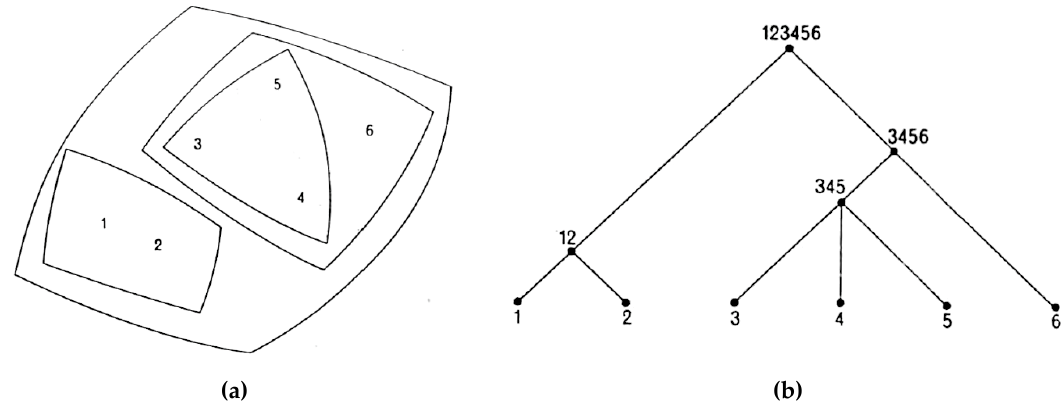
Figure 1. Alexander’s figures from “A City Is Not a Tree” [5] illustrate what he means by a “tree”, or a hierarchical structure segregating elements into well-defined sets without overlaps. Each category has its own distinct branching sub-categories, shown as a set diagram in ( a ) and a network diagram in ( b ).